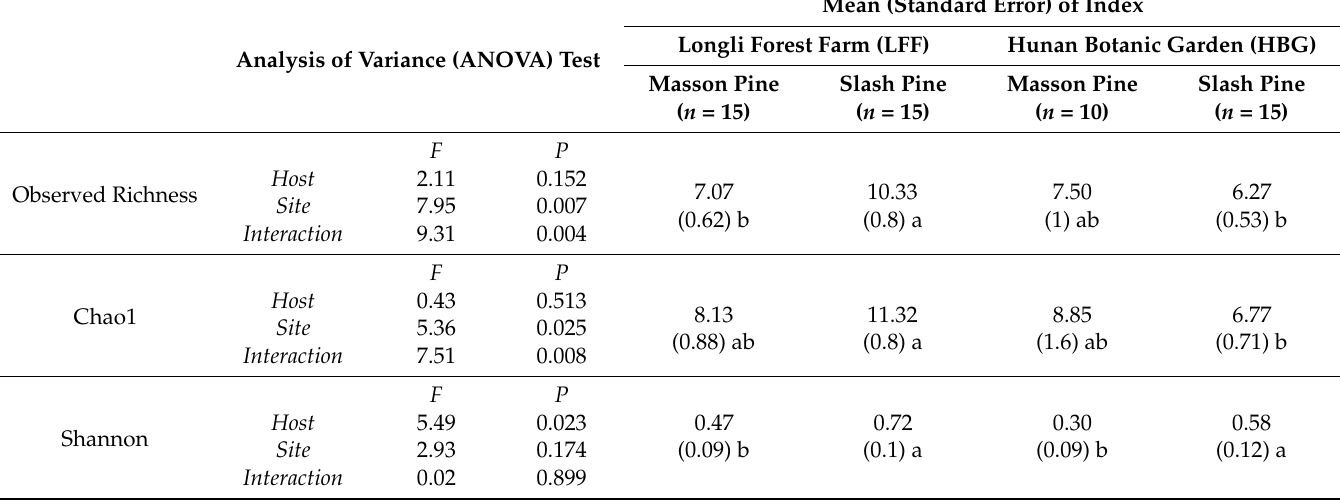
Table 2. Single-sample based observed operational taxonomic unit (OTU) richness, Chao1, and Shannon-Wiener indices for ECM fungal communities from all forest types across the sites. Different letters indicate significant differences among forest types based on Tukey Honestly Significant Difference (HSD) post-hoc test ( p <